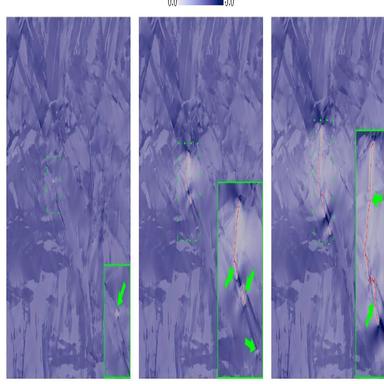
Simulated equivalent stress in the martensitic microstructure where cracks are colored in red. The loading direction is horizontal. The insets (green solid lines) show a magnification of the region around the cracks (green dashed lines) in which individual cracks are indicated by green arrows. (For interpretation of the references to color in this figure, the reader is referred to the web version of this article.)